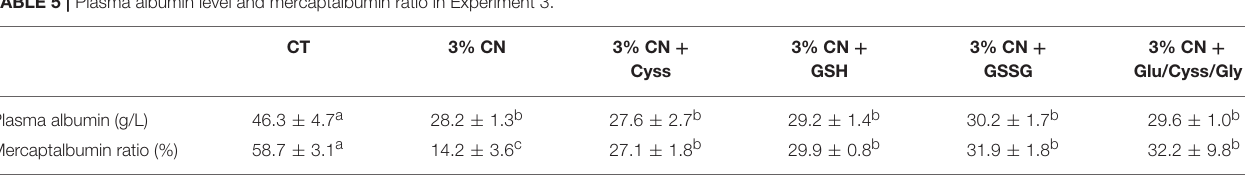
TABLE 5 | Plasma albumin level and mercaptalbumin ratio in Experiment